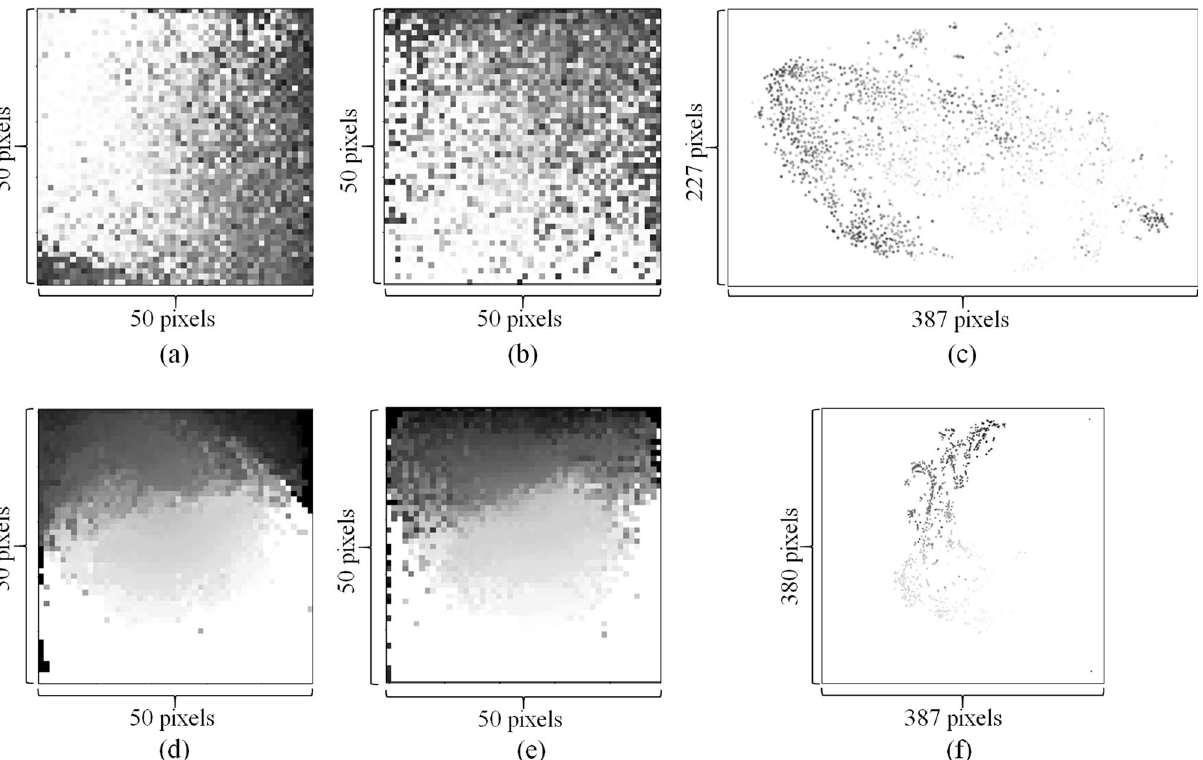
Figure 2. Example image representations of CCL gene expression profiles and drug molecular descriptors. ( a – c ) are image representations of the gene expression profile of the SNU-61 cell line generated by IGTD, REFINED, and DeepInsight, respectively. ( d – f ) are image representations of molecular descriptors of Nintedanib, generated by IGTD, REFINED, and DeepInsight,